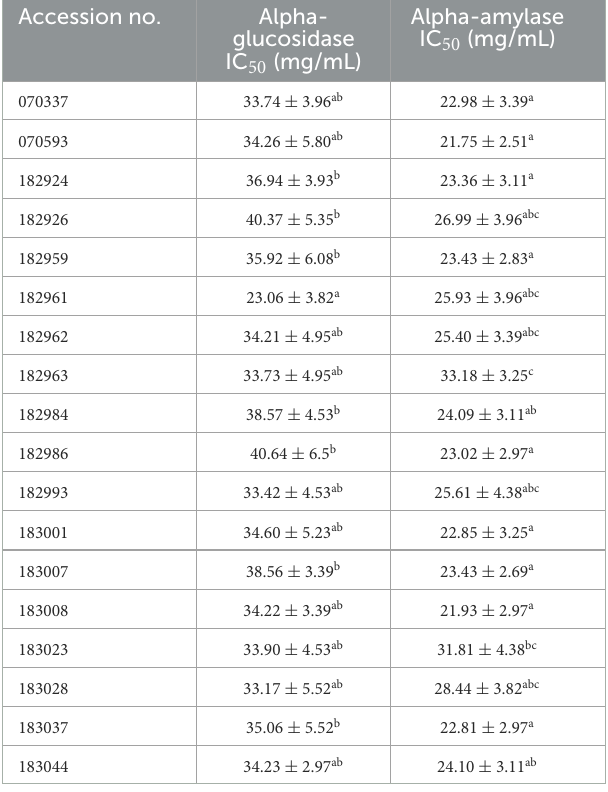
TABLE 4 Starch-hydrolysing enzymes inhibitory activity of 18 elite yellow-fleshed cassava genotypes. Accession